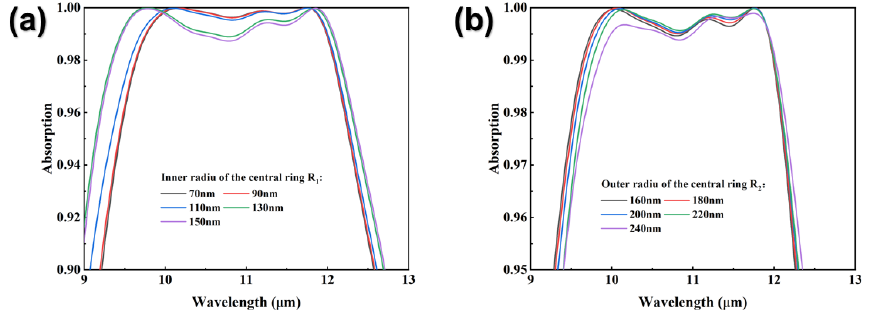
Figure 6. ( a ) Absorption spectra with different radii of the inner ring of the central circle. ( b ) Absorption spectra with different radii of the outer ring of the central circle.